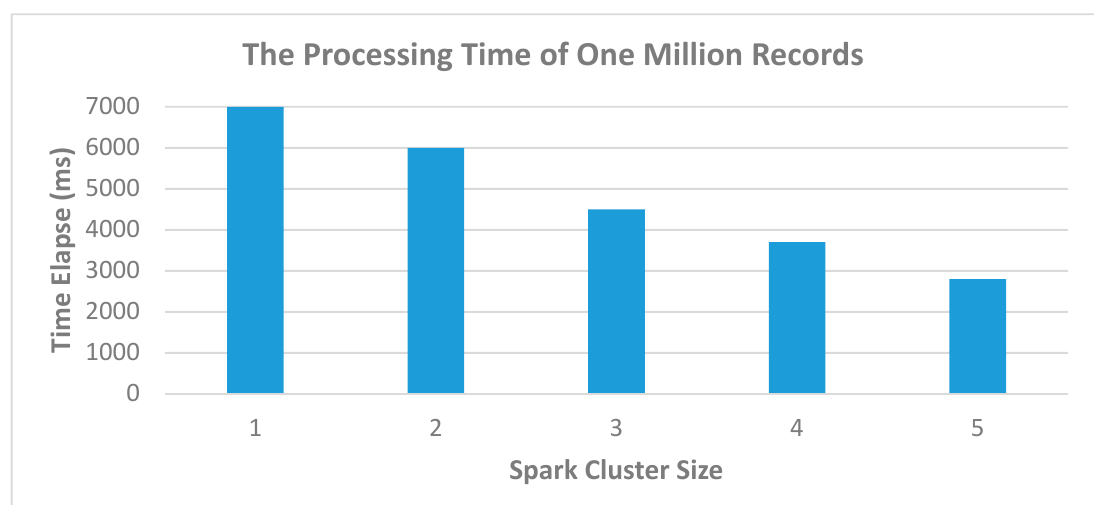
Figure 12. The Testing performance of PLCs and partitions in Kafka.